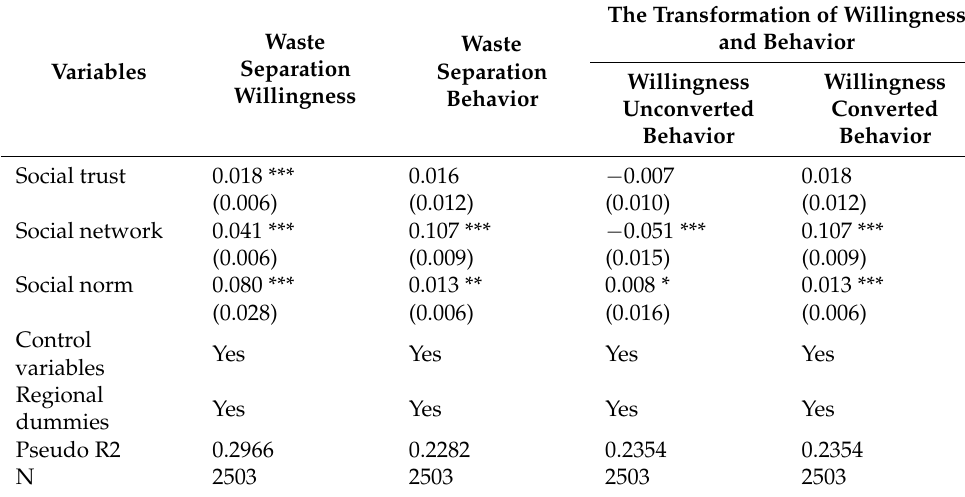
Table 5. Average treatment effects of different matching